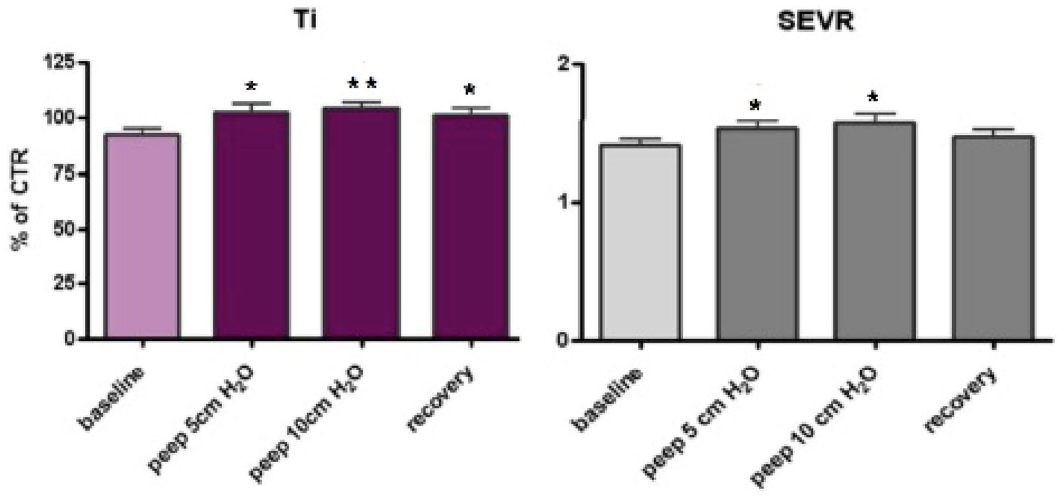
Figure 2. Clustered column for Ti (chart on the left) and SEVR (chart on the right) from baseline to Recovery; significant difference observed for Ti from baseline to PEEP = 10 cmH 2 O and from baseline to recovery; significant increase also for SEVR from baseline to the application of PEEP = 5 cmH 2 O and from baseline to the application of PEEP = 10 cmH 2 O. Data are presented as mean, error bars represent standard deviation. CTR, percentage of changes in comparison to control; Ti, time to inflection point; SVER, diastolic AUC divided